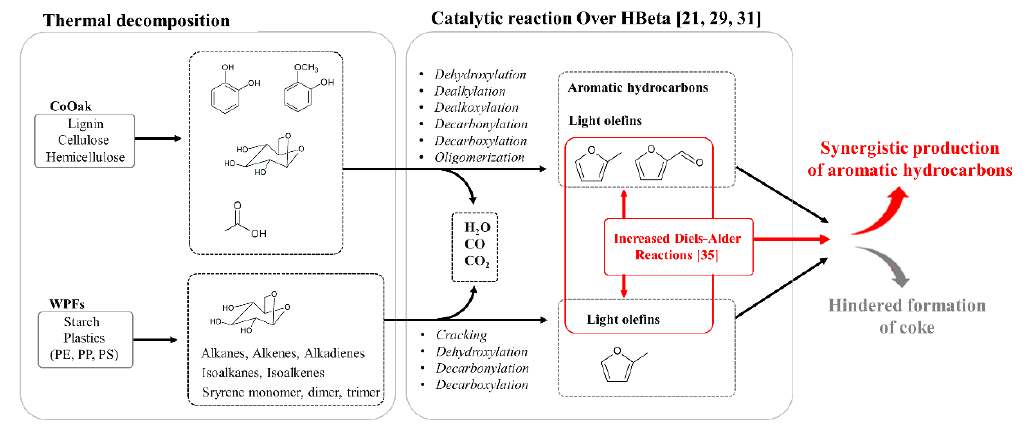
Figure 4. Possible reaction pathway for the synergistic formation of aromatic hydrocarbons during the CFCP of CoOak and WPFs over